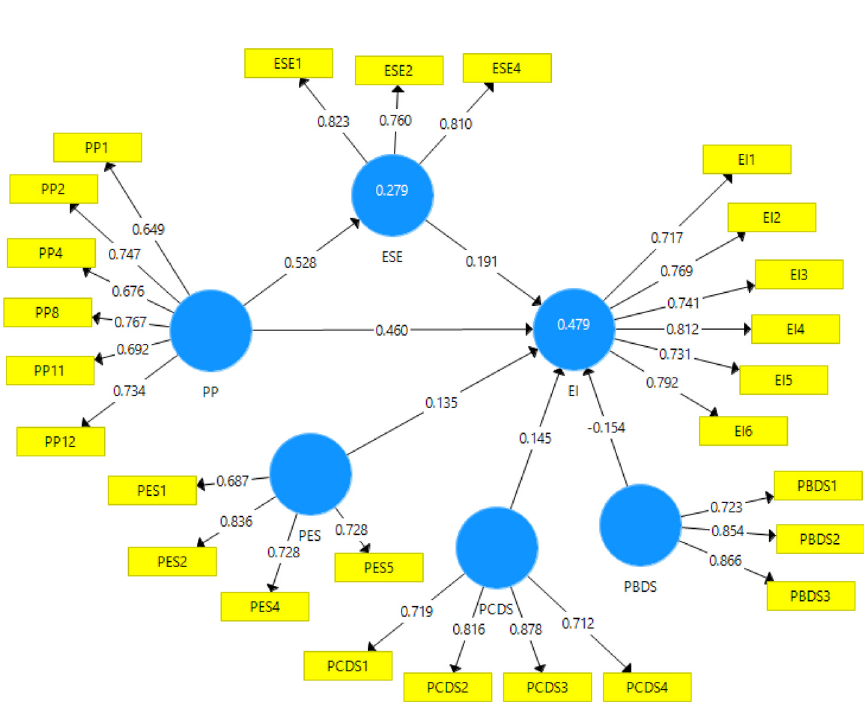
Figure 1. Research structural